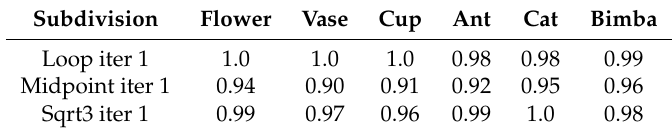
Table 11. Watermark robustness against subdivision measured in terms of correlation.